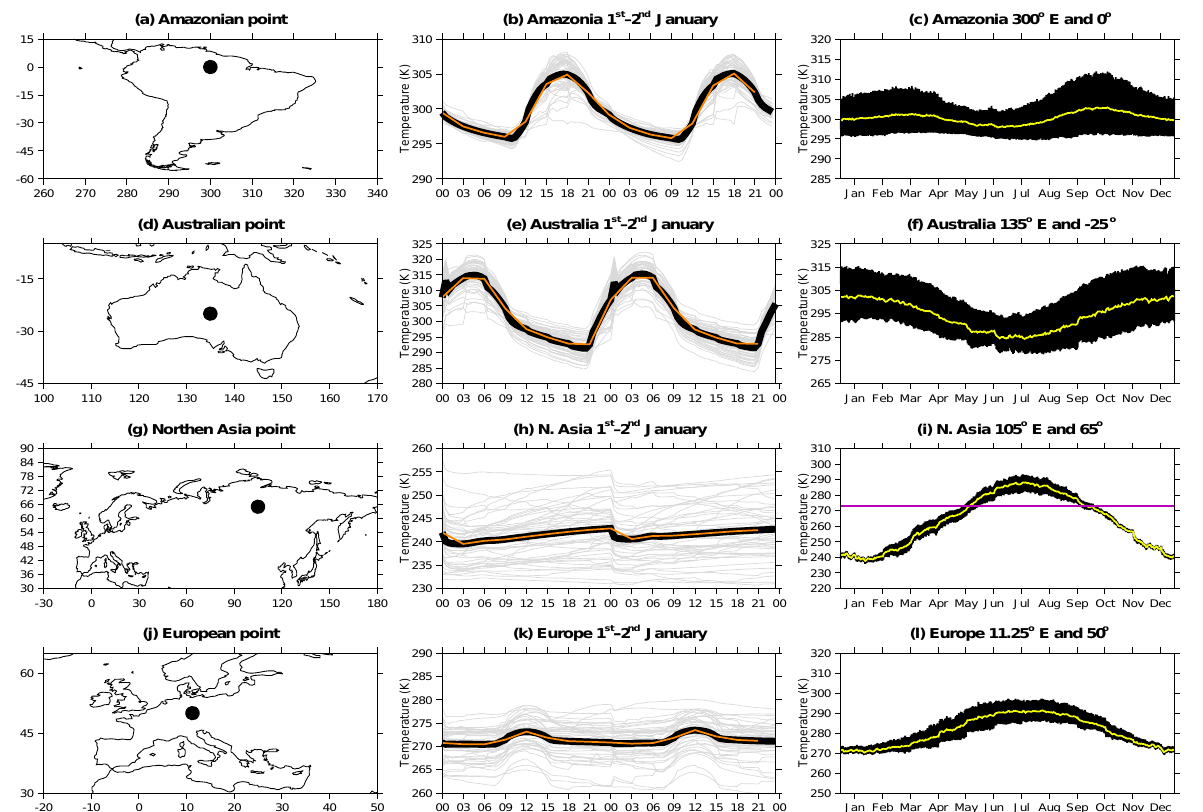
Figure 2. Examples of how the surface temperature (K) inputs were produced at individual grid points. Left column: the locations of the example grid points. Middle column: corresponding surface temperature values for those points in the left column on 1 and 2 January. Grey lines are the surface temperatures for each of the 50 years, the black lines represent the time-step mean (30min) values from those 50 years on 1 and 2 January, and the orange lines represent the 3-hourly input–hourly interpolated temperature field described in Sect. 2.2.2. Right column: the time-step mean values (black line) and the daily mean surface temperature (yellow line, which highlights the seasonal cycle) The magenta line in (i) indicates 273.15 K (i.e. the freezing temperature of liquid